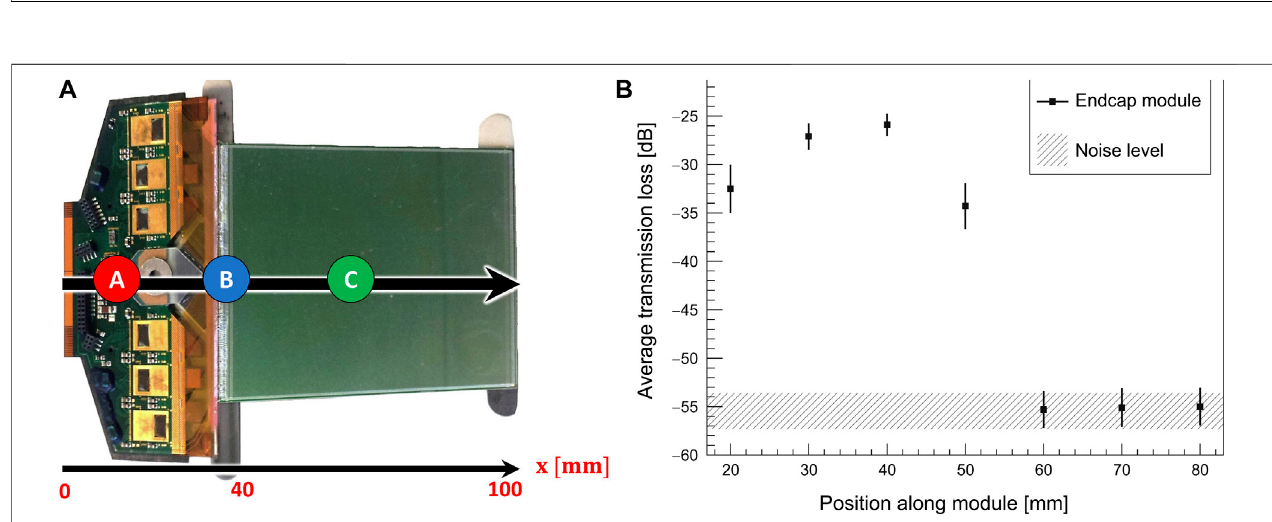
FIGURE 5 | (A) The ATLAS SCT endcap module under test. Positions for frequency scans are denoted by (A) , (B) and (C) . A position scan is performed along the black arrow. (B) Transmission loss of the endcap module averaged over the frequency band for a position scan (along the arrow in panel 5A) [26].